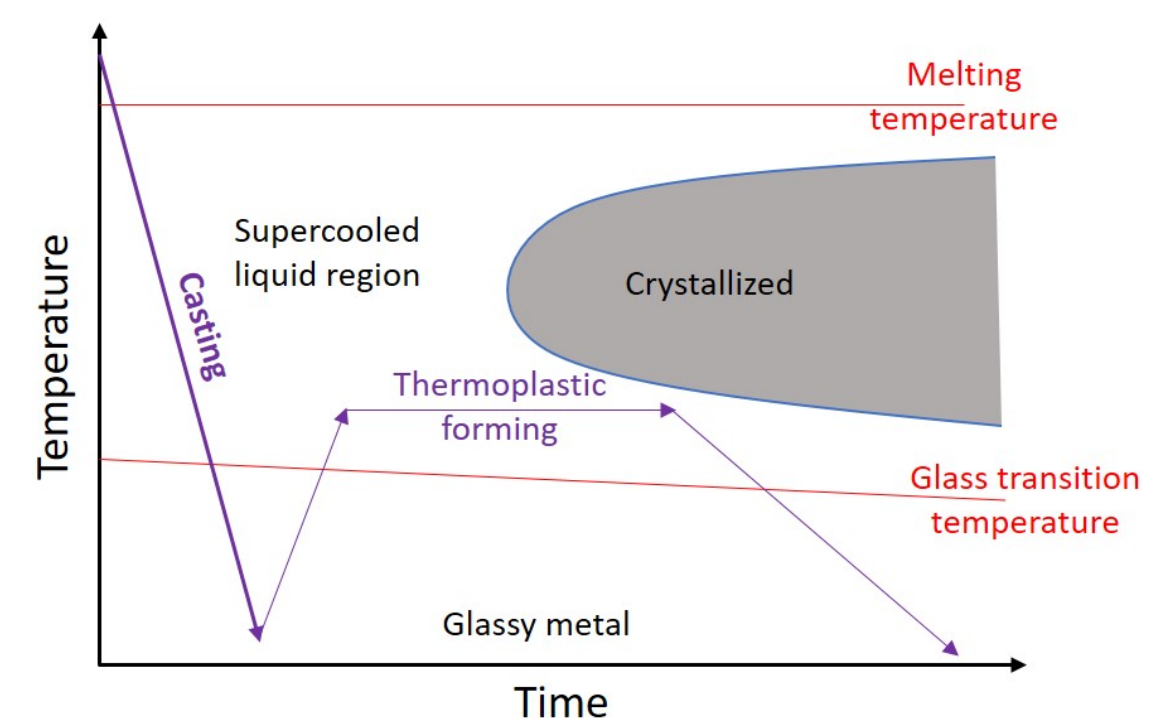
Figure 1. Schematic time–temperature–transformation (TTT) diagram showing processing windows for direct casting and thermoplastic forming of BMGs.